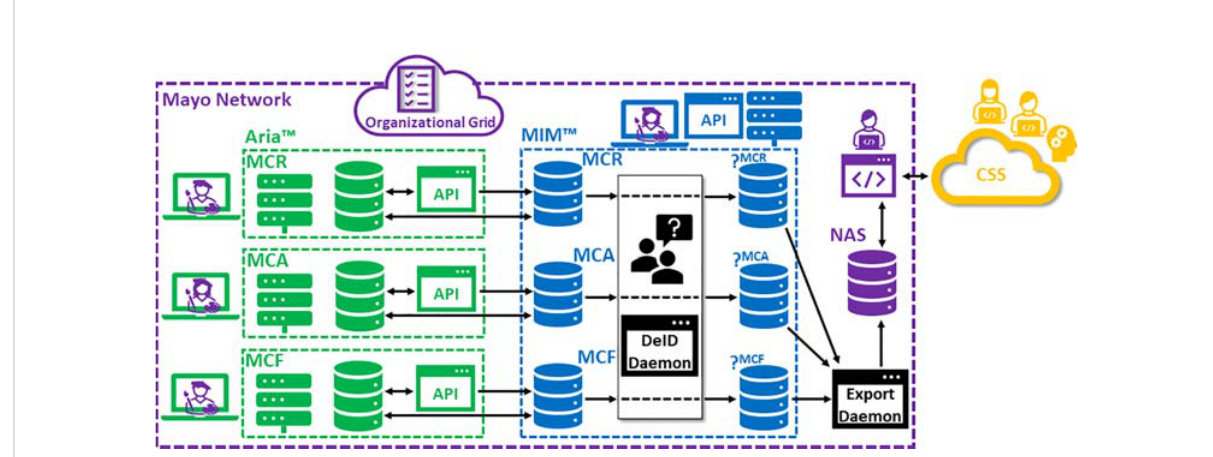
FIGURE 1 Schematic of technical curation infrastructure. (MCR, Mayo Clinic Rochester; MCA, Mayo Clinic Arizona; MCF, Mayo Clinic Florida; DeID, de-identi fi cation; CSS, Cloud Storage